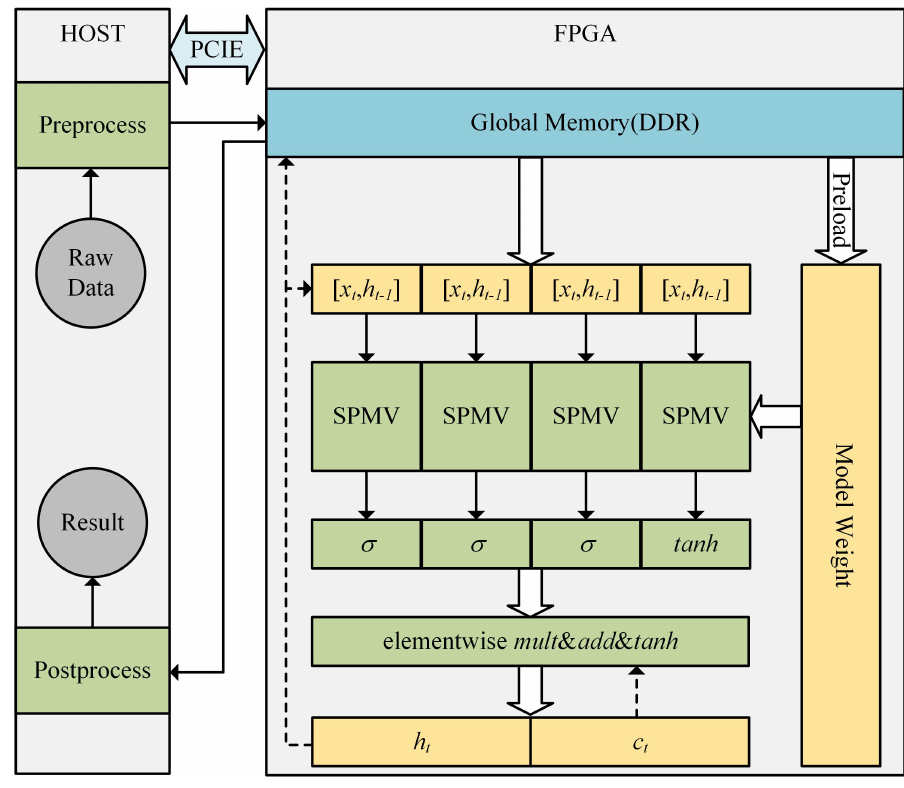
Figure 3. System architecture of